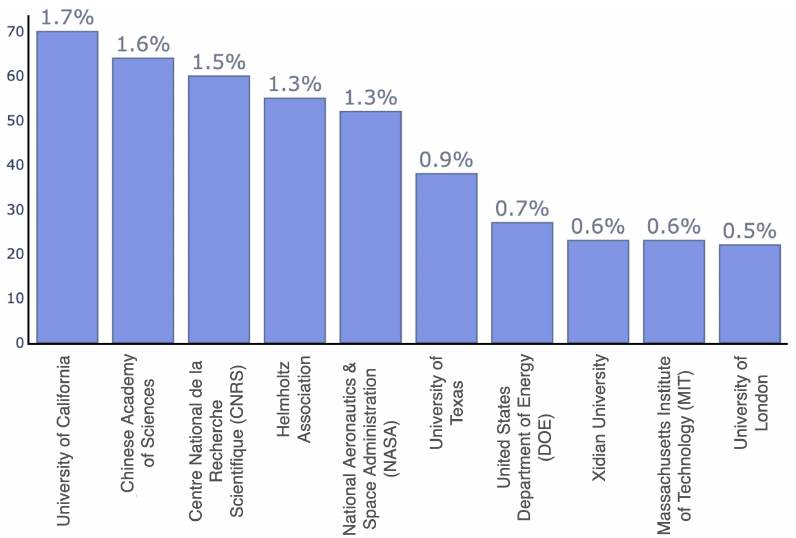
Figure 6. The institutions with the most publications from the WoS-filtered results. The vertical axis represents the number of publications. The percentages above the bars indicate the relative frequency of each institution in terms of publications.